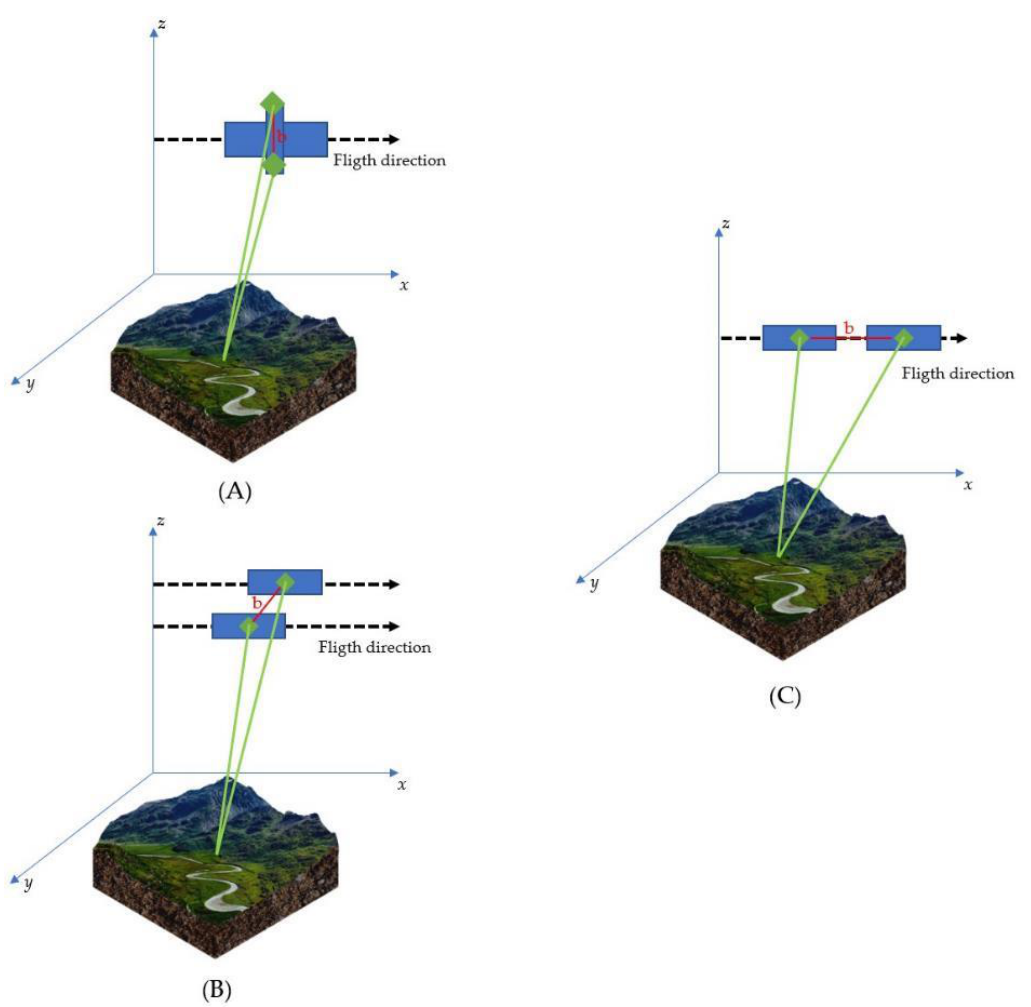
Figure 1. InSAR interferometry configurations: (A) single-pass across-track, (B) repeat-pass across-track and (C) along-track.